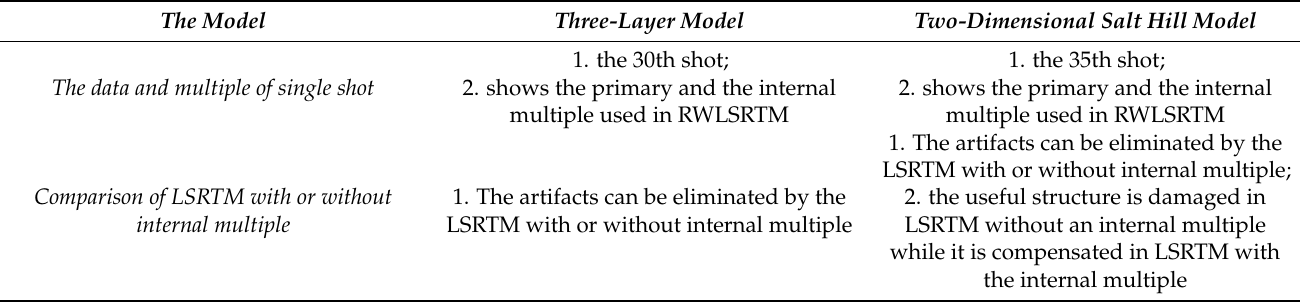
Table 1. The main content and conclusion of the numerical test. The Model Three-Layer Model Two-Dimensional Salt Hill Model 1. the 30th shot; 1. the 35th shot; The data and multiple of single shot 2. shows the primary and the internal 2. shows the primary and the internal multiple used in RWLSRTM multiple used in RWLSRTM 1. The artifacts can be eliminated by the LSRTM with or without internal multiple; Comparison of LSRTM with or without 1. The artifacts can be eliminated by the 2. the useful structure is damaged in internal multiple LSRTM with or without internal multiple while it is compensated in LSRTM